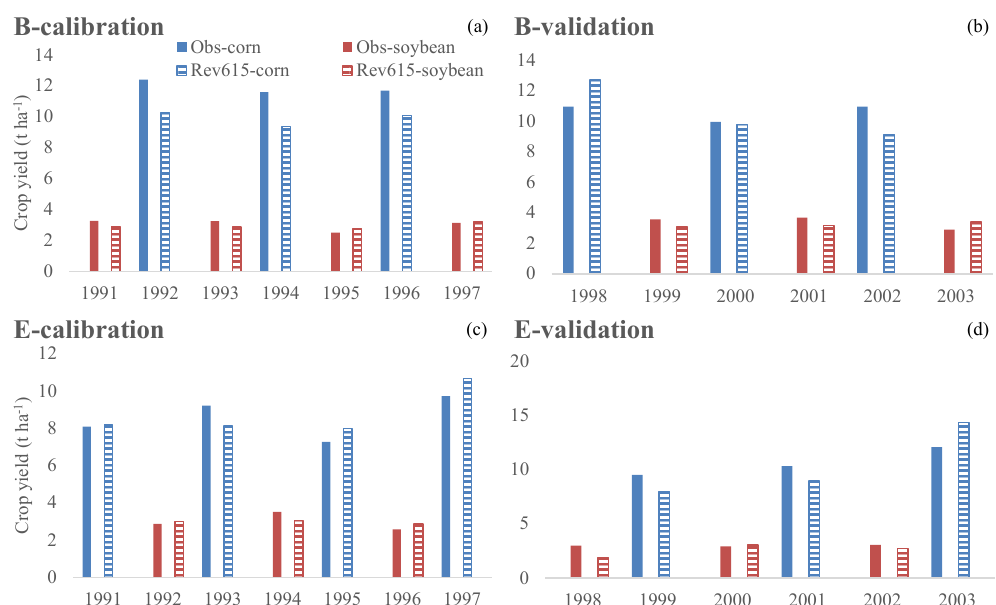
Figure 2. Calibration and validation results for annual crop yields at sites B (a, b) and E (c, d) . Obs and Rev. 615 represent Observed and Rev. 615,